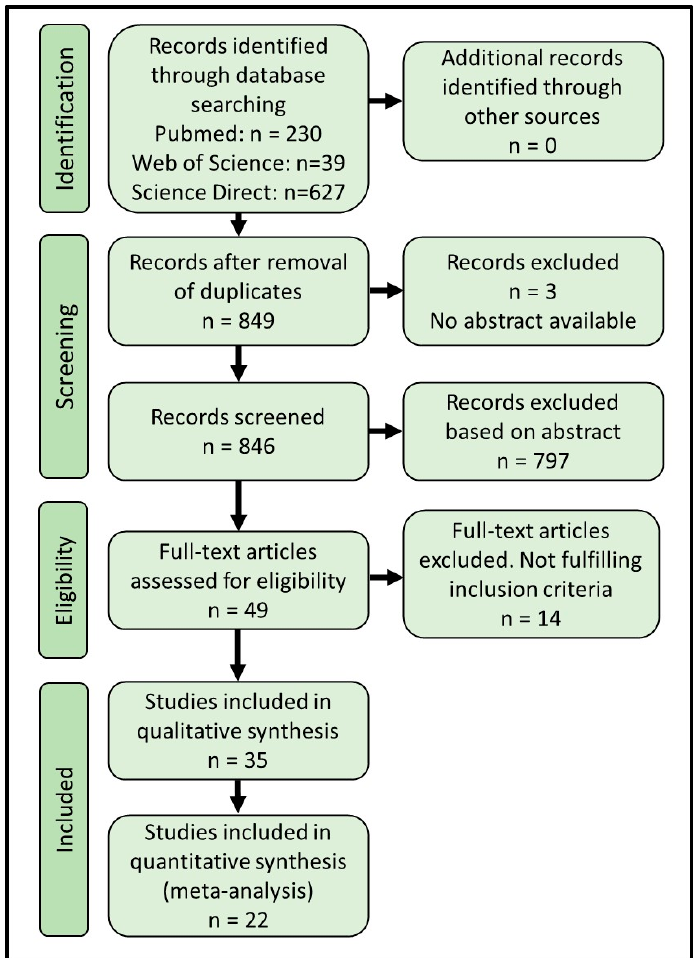
Figure 1. PRISMA fl ow diagram showing the search and inclusion numbers of the systematic Figure 1. PRISMA flow diagram showing the search and inclusion numbers of the systematic review.